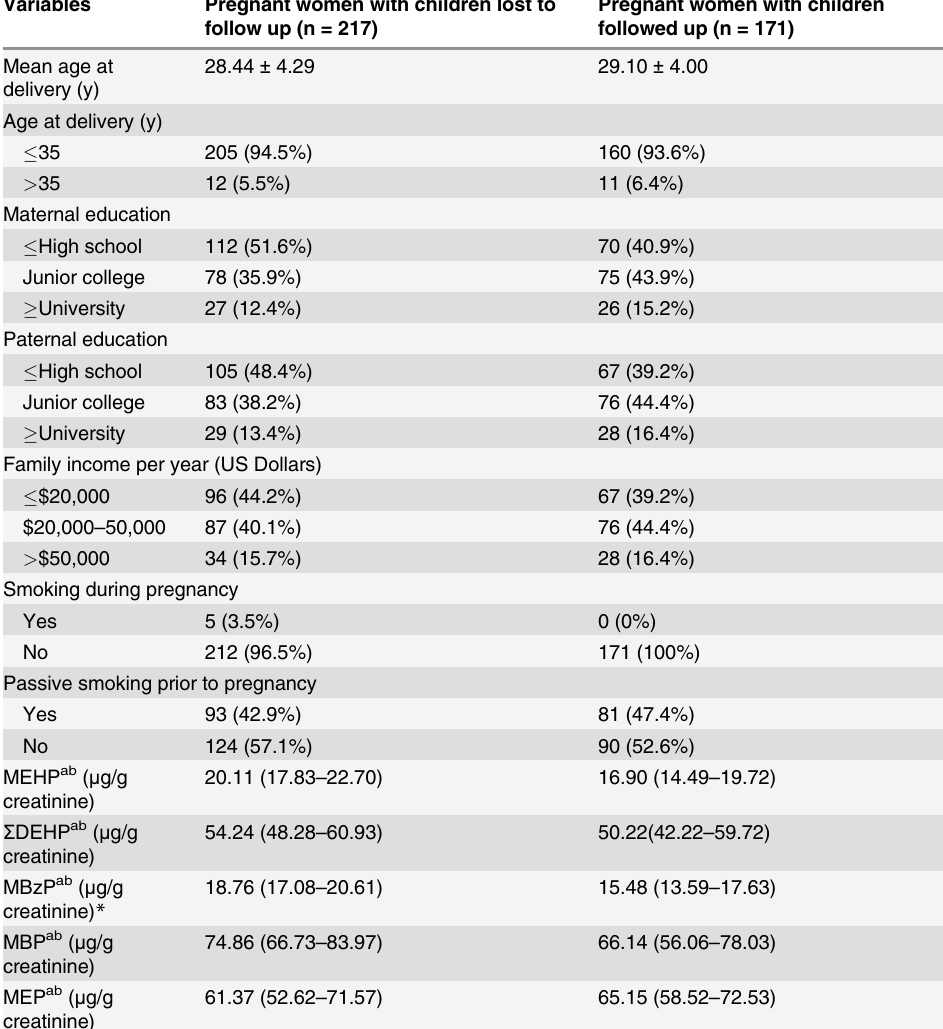
Table 1. Demographics and maternal urinary phthalate metabolite concentrations ( μ g/g creatinine) in pregnant women with and without children who were followed up for asthma at 8 years of age. Variables Pregnant women with children lost to Pregnant women with children follow up (n = 217) followed up (n = 171) Mean age at delivery